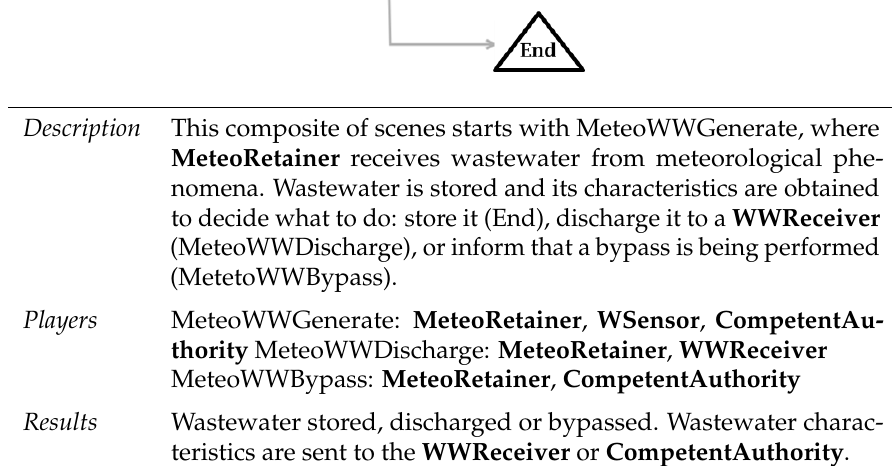
Figure A1. Landmark patterns for the meteorology discharge. It shows how meteorological wastew- ater is generated and temporarily stored to be either discharged for normal processing or bypassed to avoid an